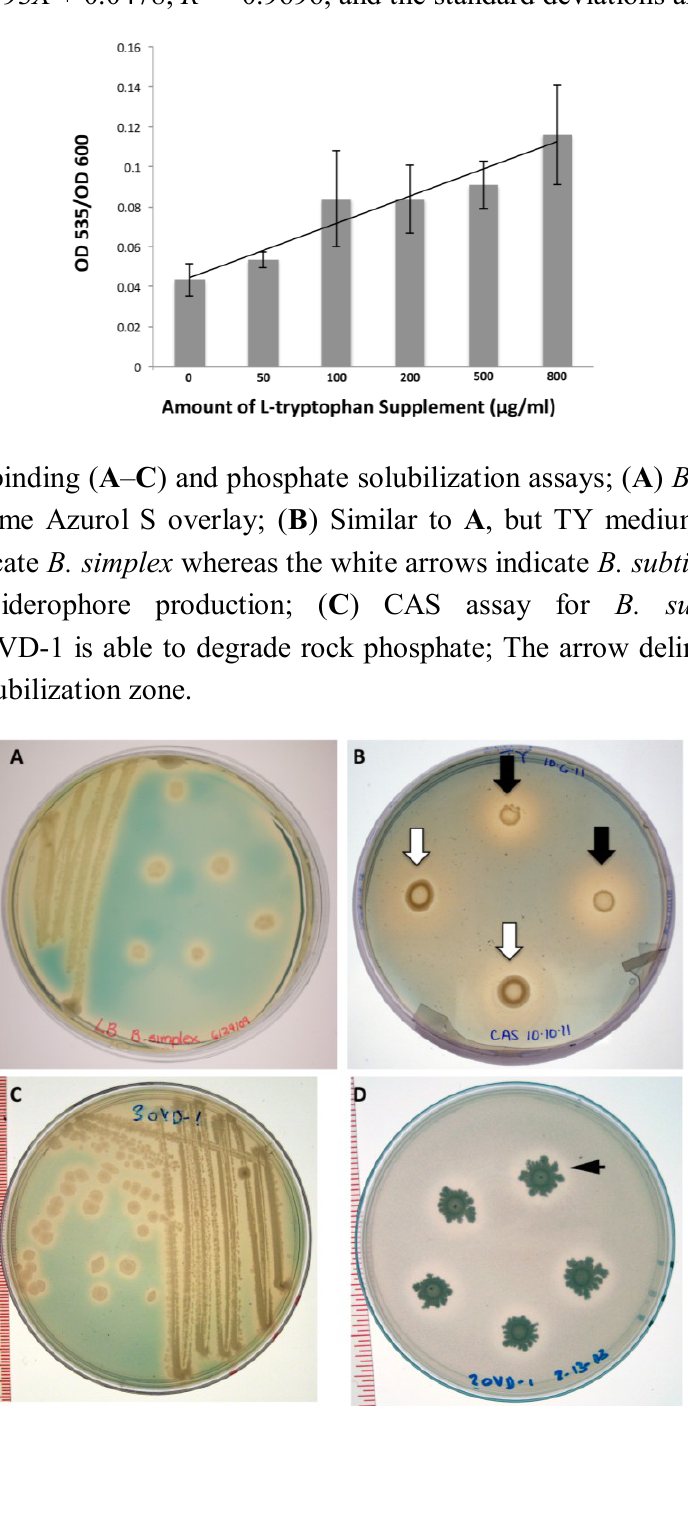
Figure A1. Colorimetric detection of auxin production from culture medium supplemented with L -tryptophan.